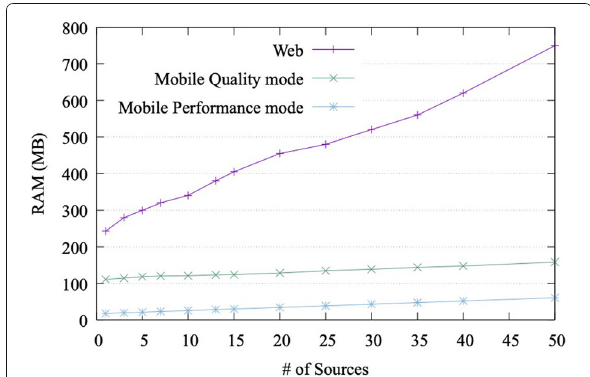
Fig. 8 Soundscape Experience memory